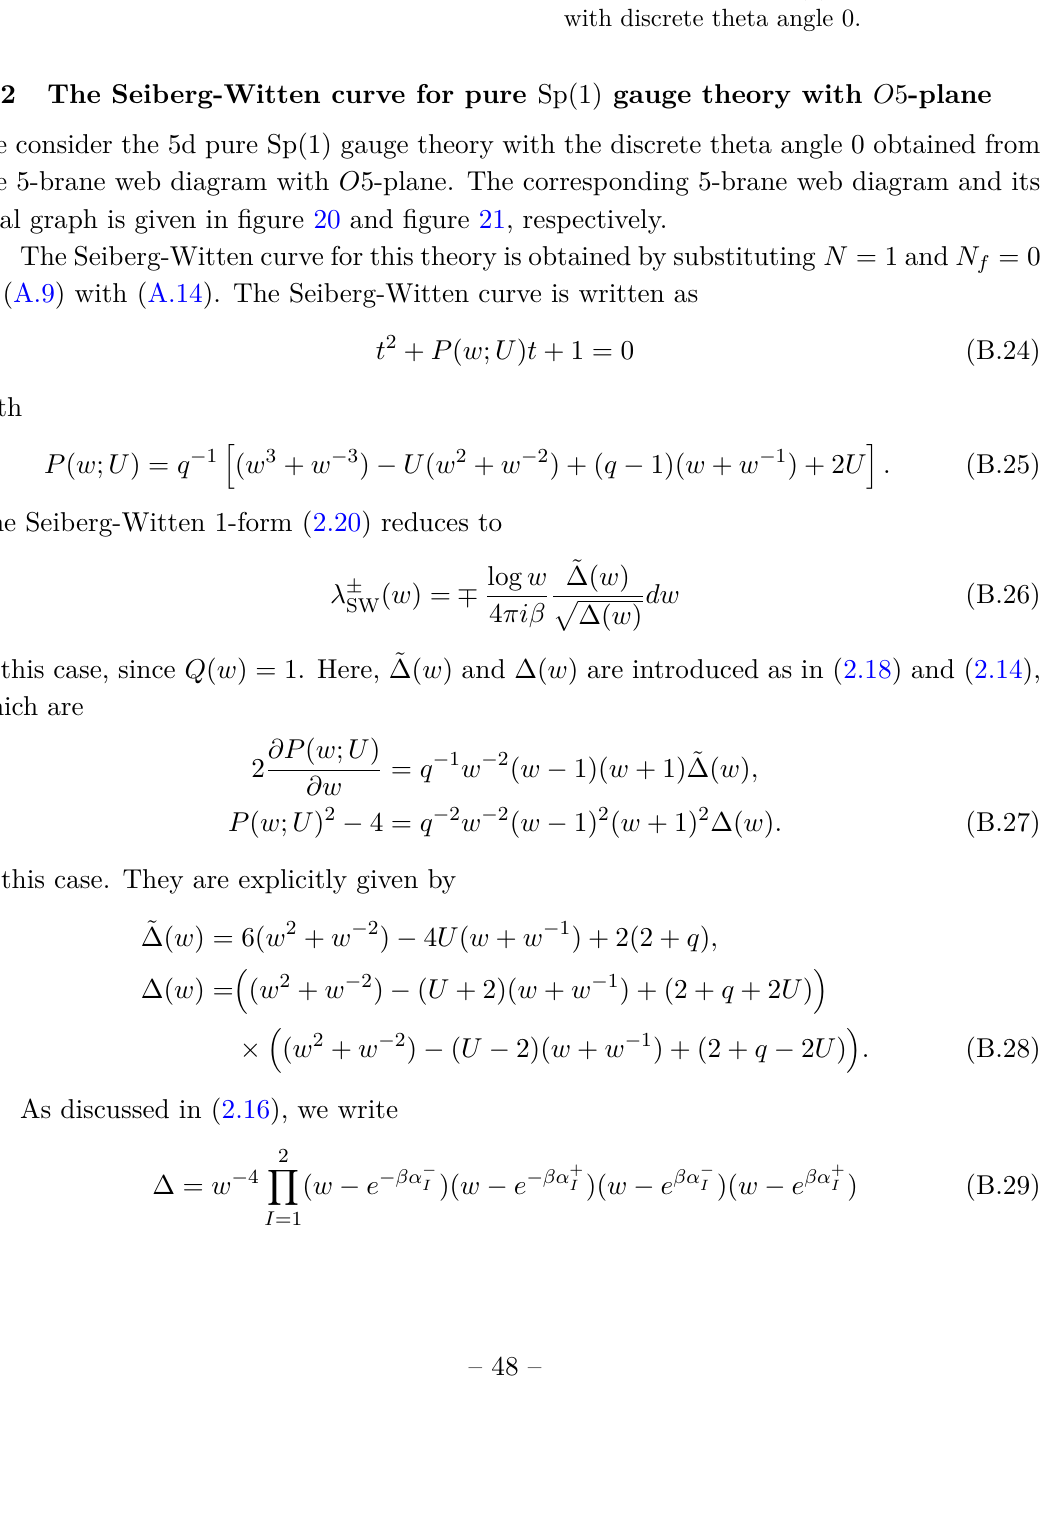
Figure 20 . 5-brane web for 5d pure Sp(1) gauge theory with discrete theta angle 0.